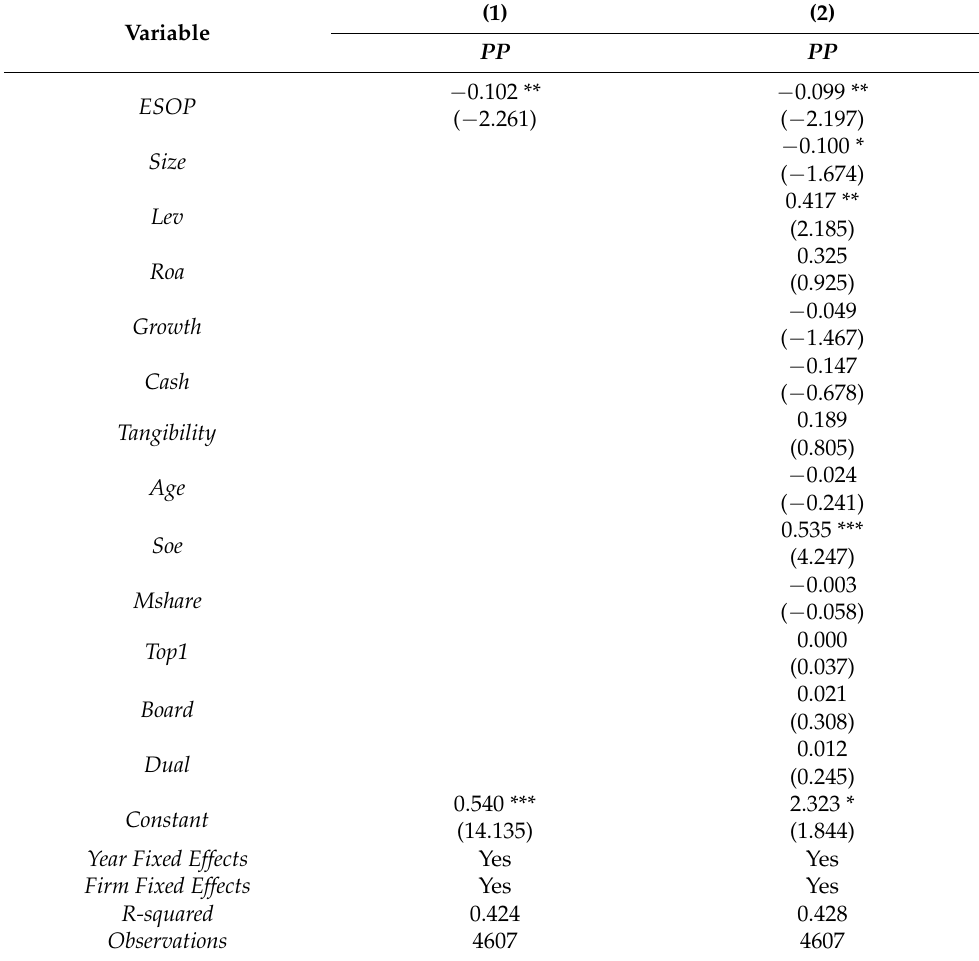
Table 4. Employee stock ownership plans and corporate environmental